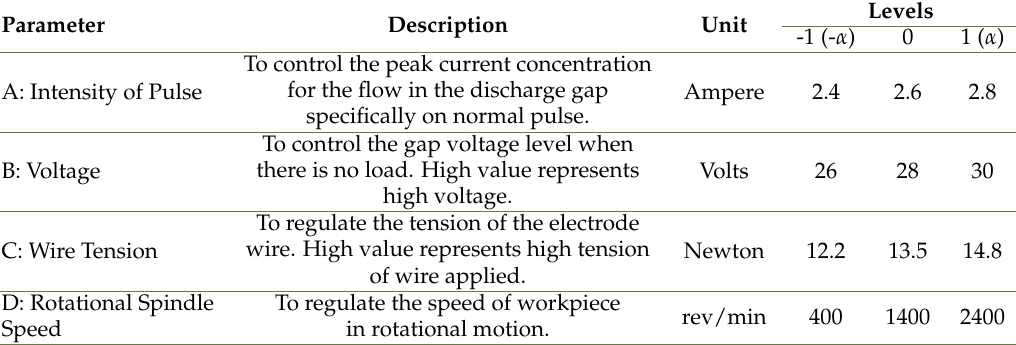
Table 2. The experimental design includes four parameters with three levels